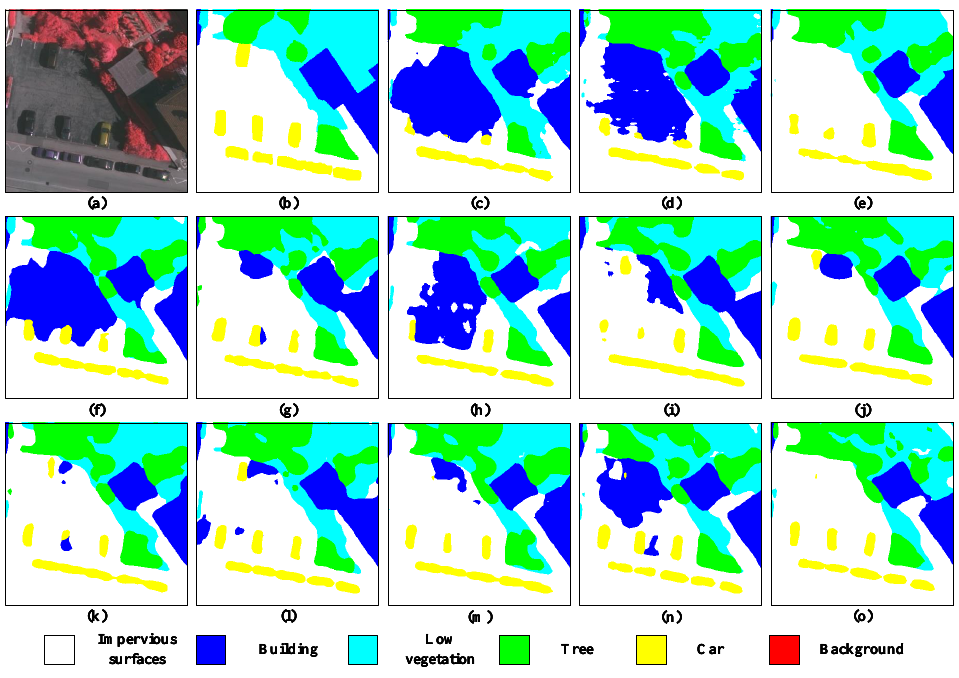
Figure 10. Examples of segmentation results derived from the Vaihingen dataset under the small size setting. ( a ) IRRG image. ( b ) Ground truth. ( c ) FPENet. ( d ) FSSNet. ( e ) CGNet. ( f ) ContextNet. ( g ) Fast-SCNN. ( h ) ESNet. ( i ) ERFNet. ( j ) DDRNet23-slim. ( k ) STDC1. ( l ) LinkNet. ( m ) BiSeNet V1. ( n ) BiSeNet V2. ( o ) DSANet64.